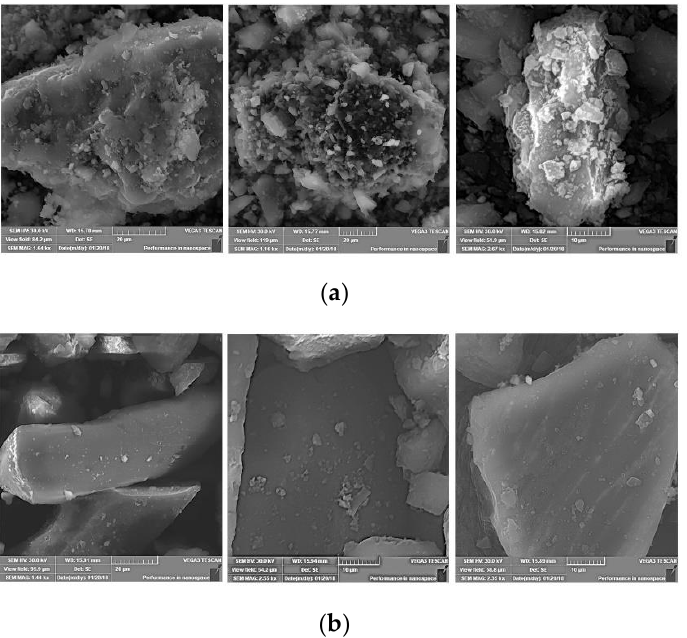
Figure 4. Particle size dissociation of artificially mixed coal sample.